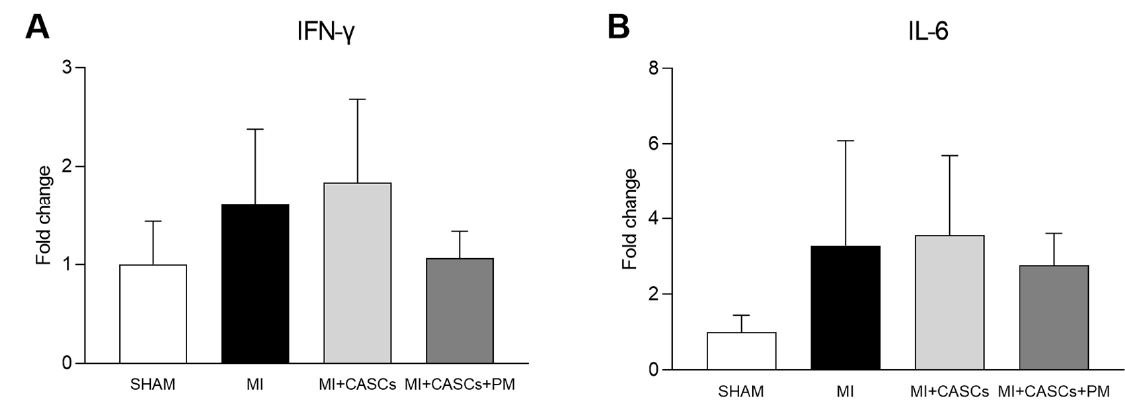
Figure 5. Gene expression of inflammatory cytokines. Quantification of gene expression of ( A ) IFN- γ and ( B ) IL-6 in LV tissue from SHAM ( n = 4), MI ( n = 7), MI + CASCs ( n = 7), and MI + CASCs + PM ( n = 3). Data are expressed as mean ± SEM.